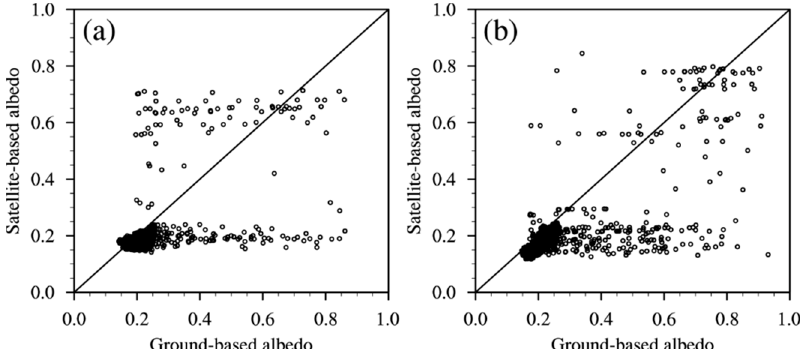
Figure 11. Scatter plots of the blue-sky-albedo of MCD43A3 and daily ground-based observation at ( a ) Maqu site from January 2009 to June 2017 and ( b ) Maduo site from January 2011 to June 2017.